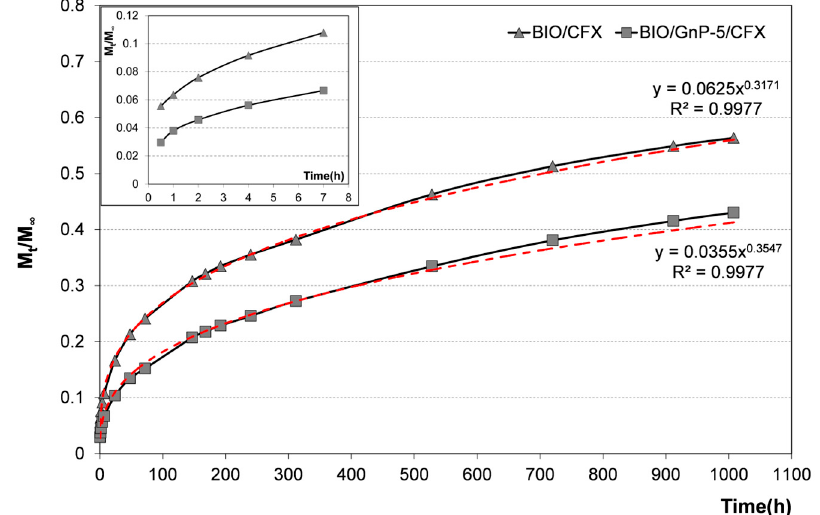
Figure 6. Cumulative CFX release from BIO/CFX and BIO/GnP-5/CFX. In the inset, only the first hours of release are plotted in order to enhance their readability. The power trend-lines fitting the experimental data (red dashed lines) are reported in the graph together with the respective equations and the R 2 values.